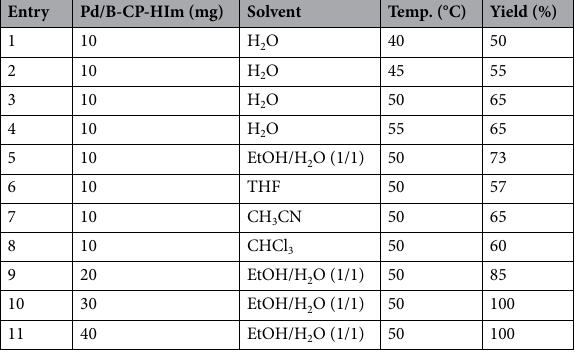
Table 1. Optimization of the reaction condition for the hydrogenation of